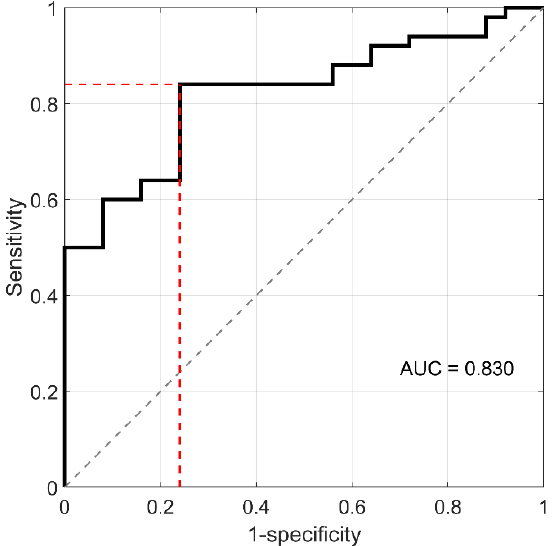
Figure 2. Receiver operating characteristic (ROC) curve obtained by LDA in the two-parameter domain of the 20–30 kDa integral area and 37–80 kDa integral area.